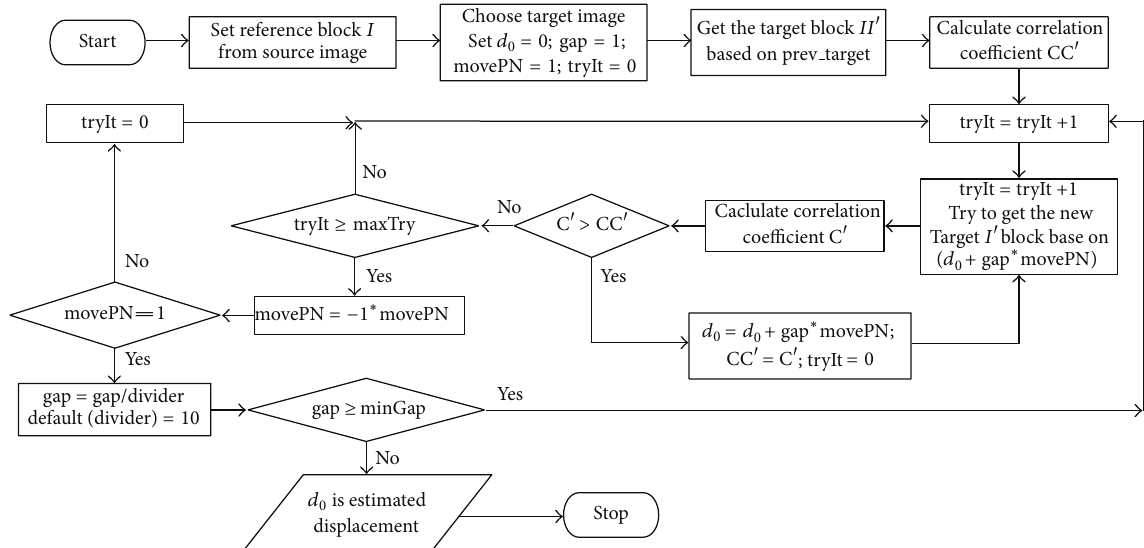
Figure 8: Flowchart of displacement evaluation algorithm, which has better execution time and accuracy than that in our earlier work.